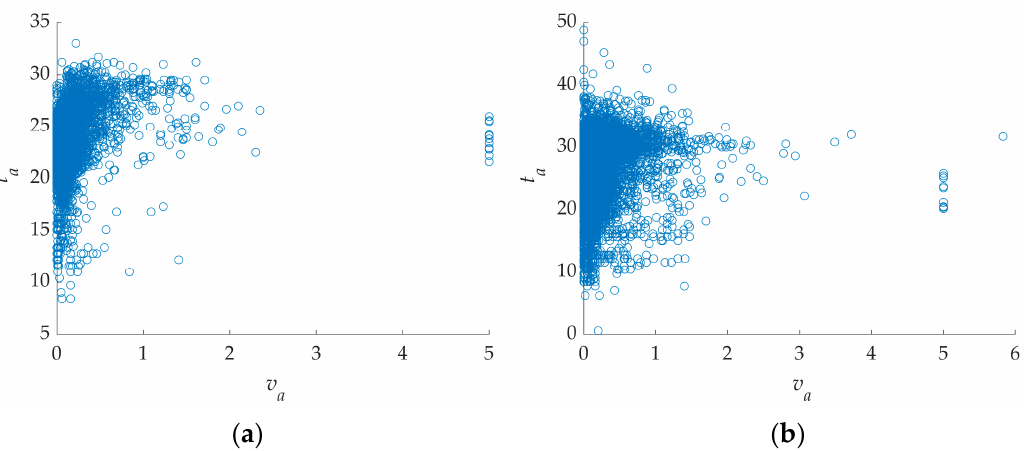
Figure 3. Sample points divided via optimum comfort interval; ( a ) sample points with PMV values fall within [ − 0.5, 0.5]; ( b ) sample points with PMV values do not fall within [ − 0.5, 0.5].